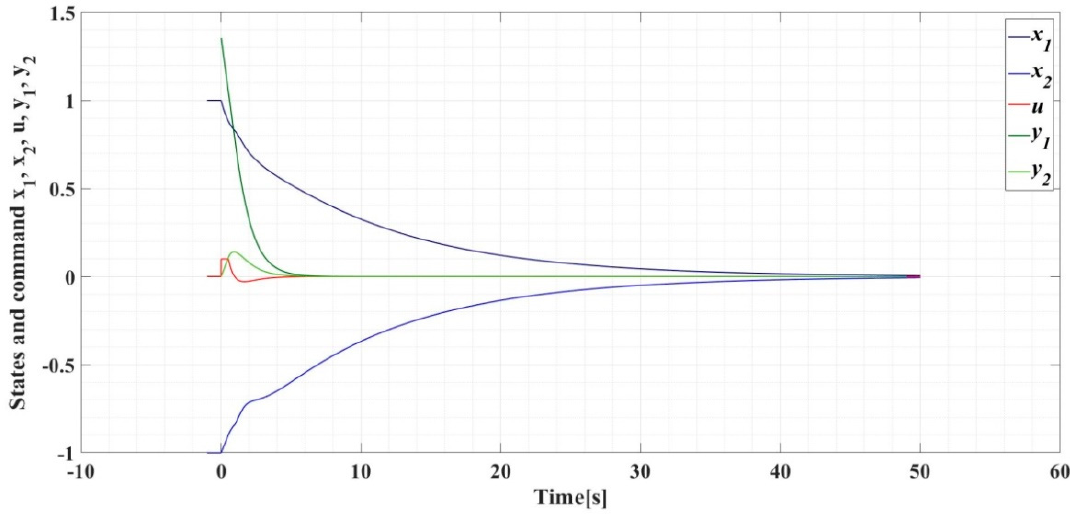
≤ u . Figure 2. Evolution of the states with | u | ≤